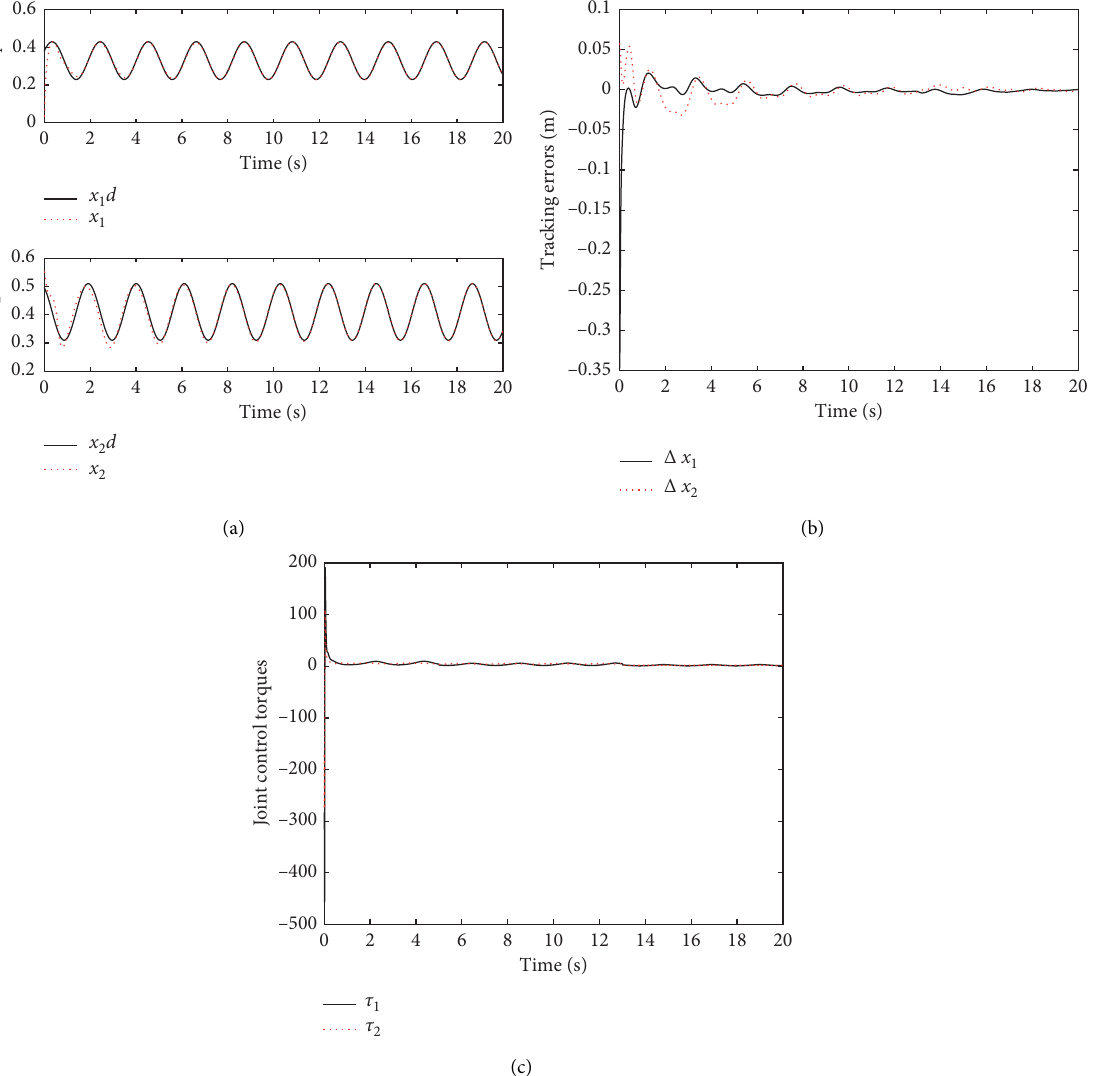
Figure 3: End-effector position tracking performance with actuator parameters perturbation. (a) Tracking performance. (b) Tracking errors. (c) Control